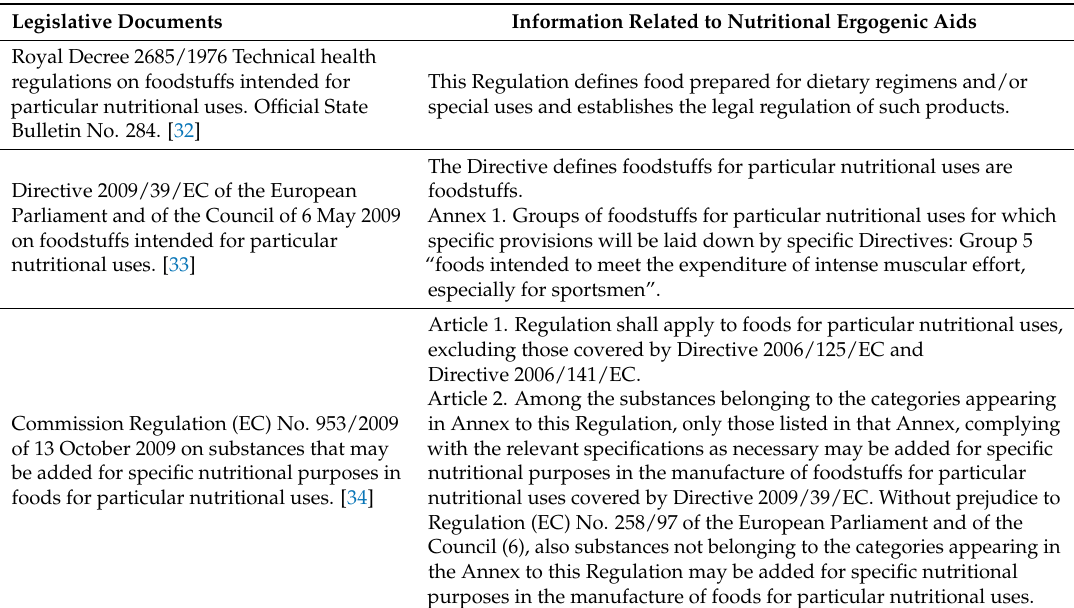
Table 3. Specific legislative documents on nutritional ergogenic